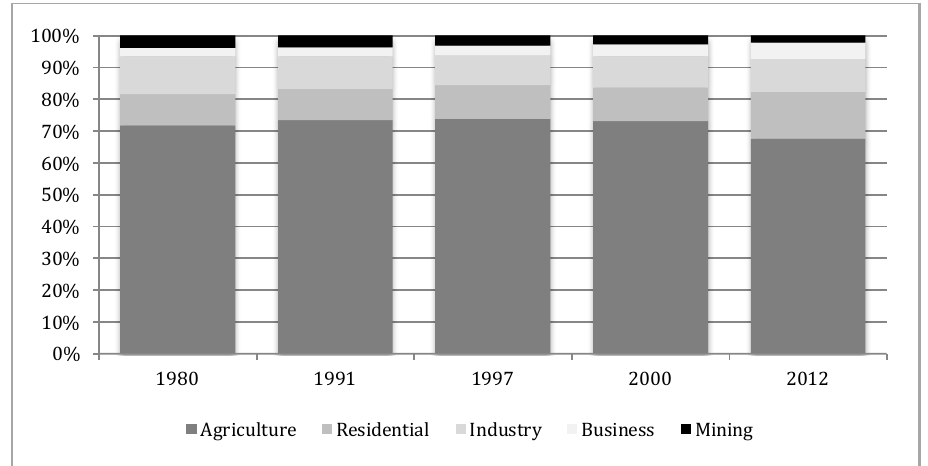
South African water use per economic activity: